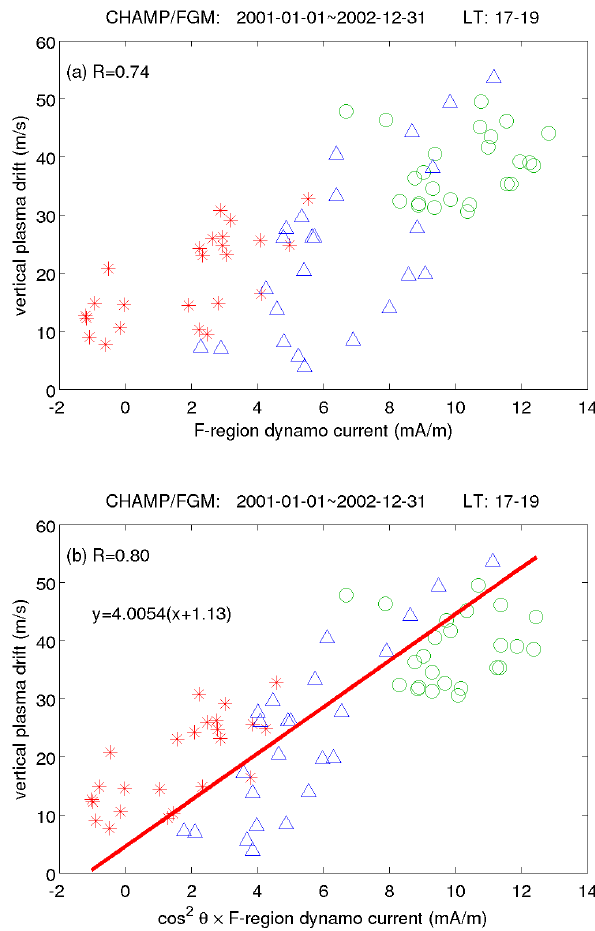
Fig. 3. Relation between PRE and (a) F-region dynamo current, and (b) F-region dynamo current multiplied by assumed conductiv- ity gradients. Data points are the same as in Fig. 2. Circles, aster- isks, and triangles represent equinox, June solstice, and December solstice readings,